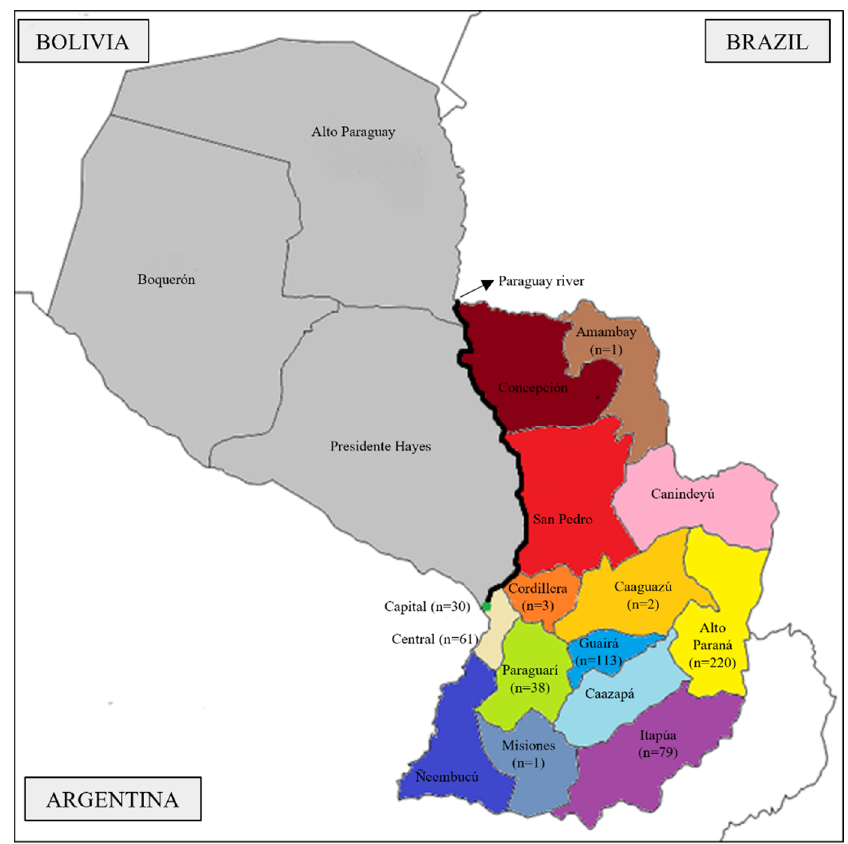
Figure 1. Map of Paraguay delimited by the surrounding countries of Argentina, Brazil, and Bolivia. Paraguay river (black line) separates the western departments (grey) from the eastern departments (colors). The information on the number of samples collected from each department, according to individuals’ living places, is indicated.